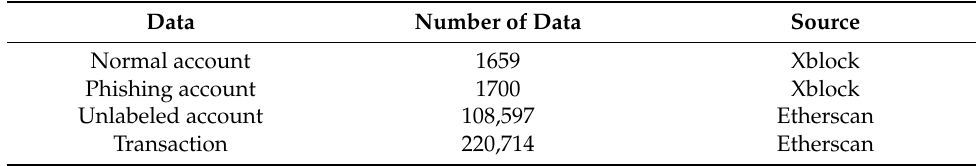
Table 2. Summary of collected